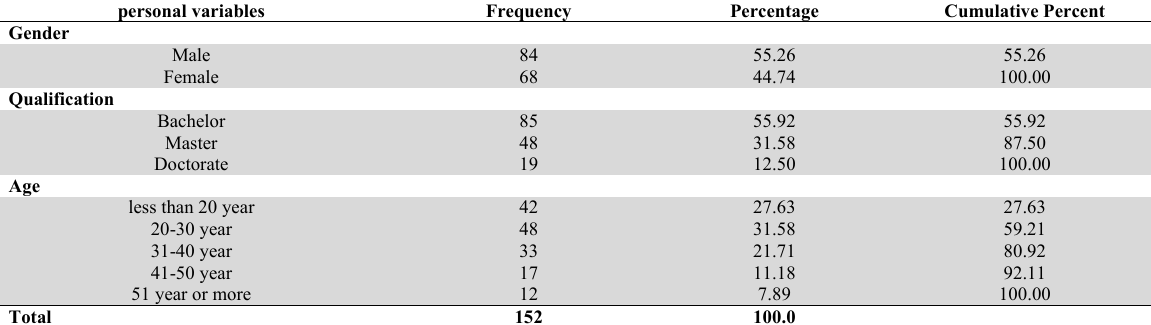
The distribution of study sample depends on personal variables n =